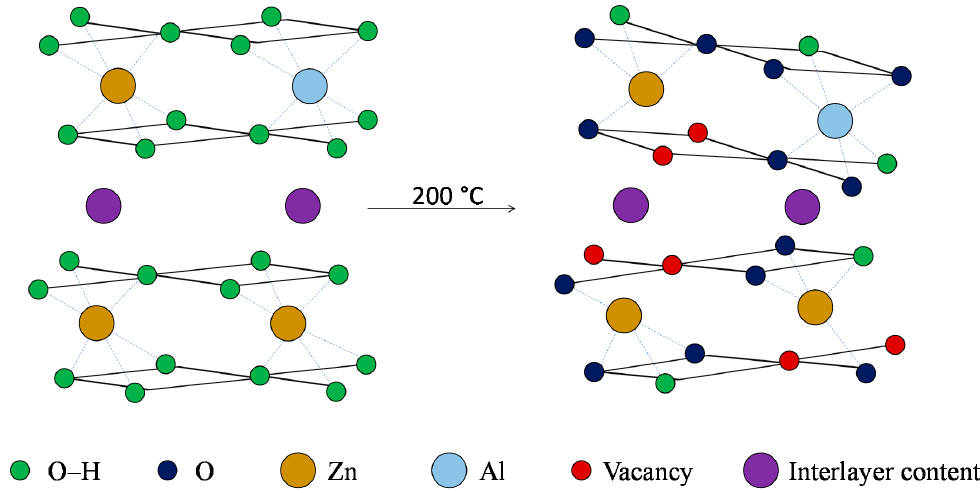
Figure 4. Schematic overview of the dehydroxylation of LDHs at low temperatures.